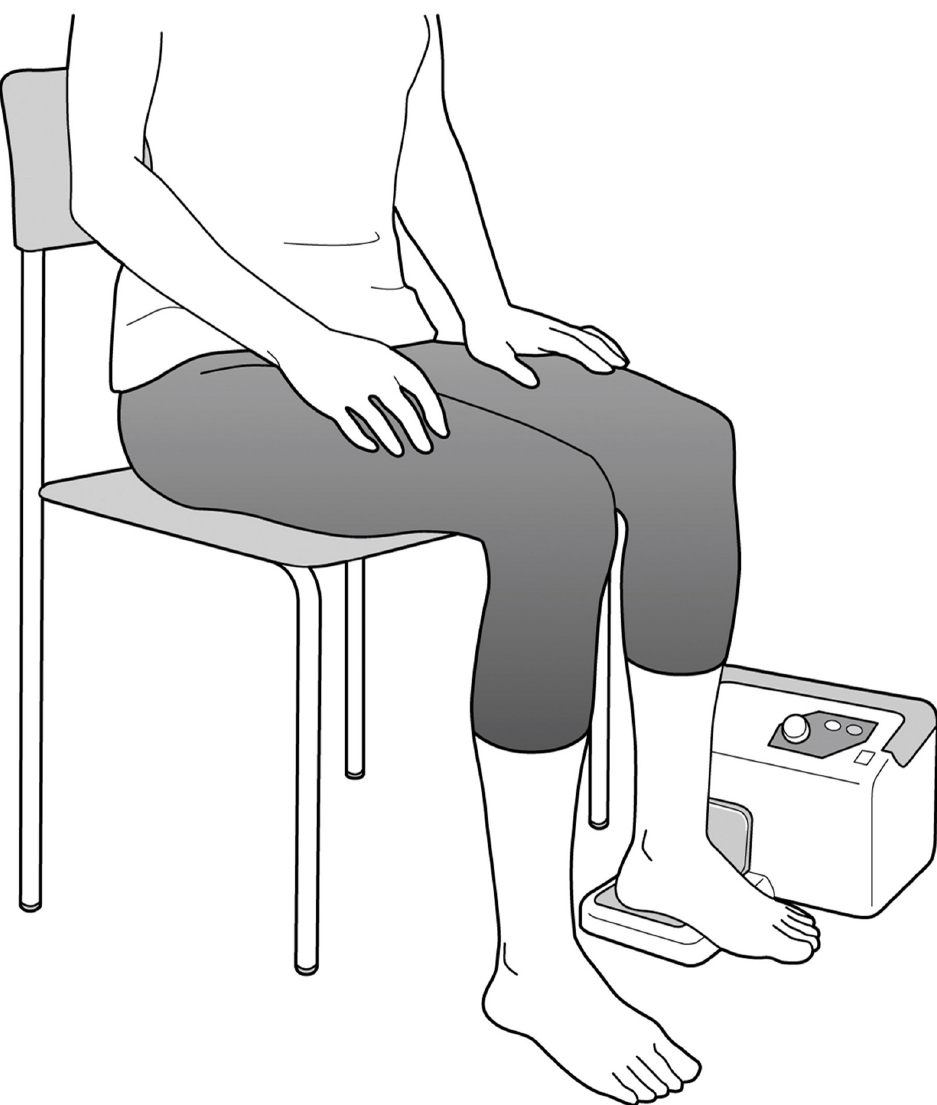
Fig 1. Method of jiggling exercise. KENKO YUSURI 1 vibrates with the patient’s heel to automate rapid, short, up- and-down movements. The jiggling exercise was performed on a chair in the sitting position to avoid deep flexion of the